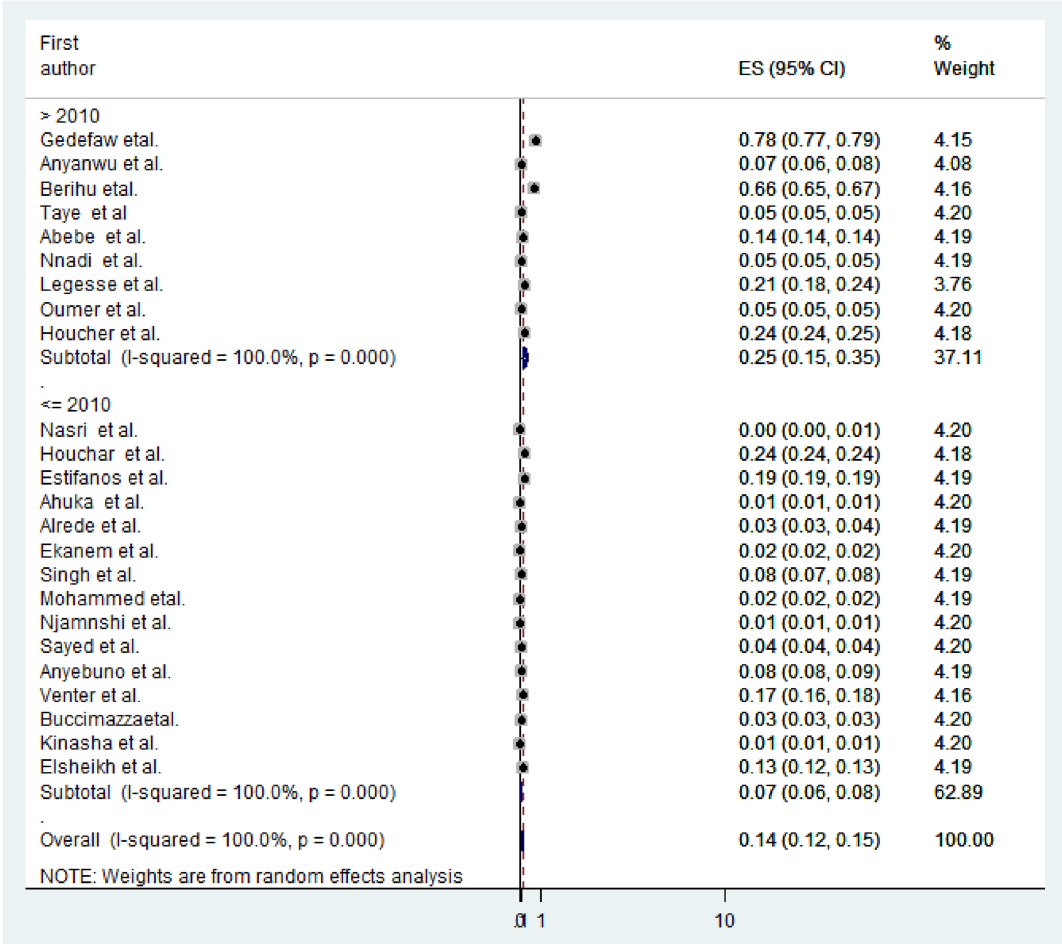
Figure 4. Sub-group analysis showing the pooled prevalence of anencephaly based on period prevalence in Africa,